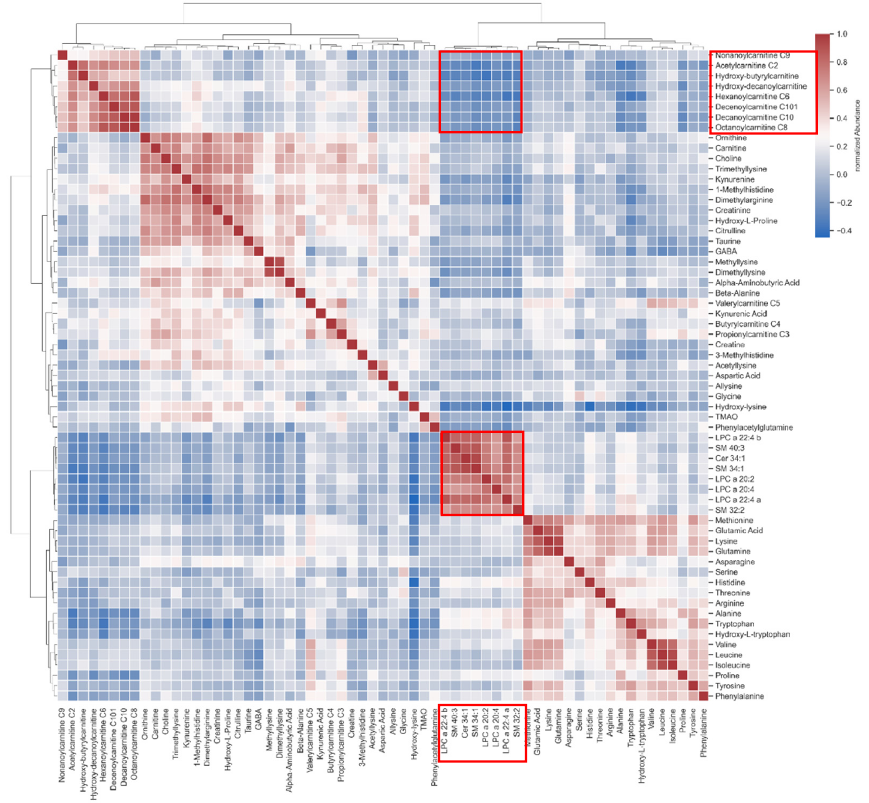
Figure 3. Correlation heatmap showing an interaction of lipids with acyl-carnitines (marked with red squares).